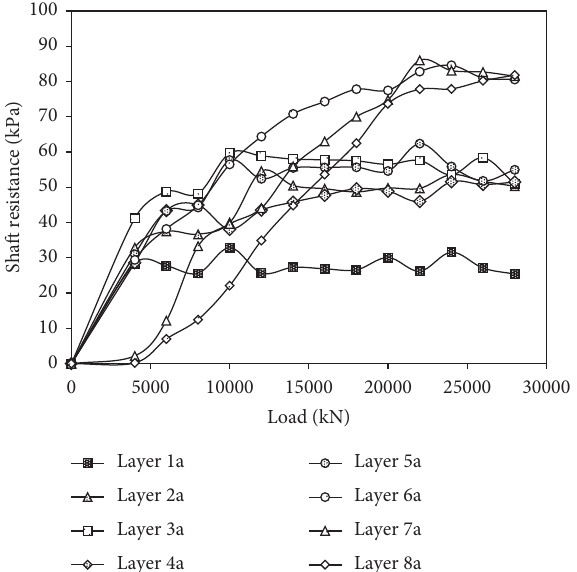
Figure 15: Shaft resistance development of